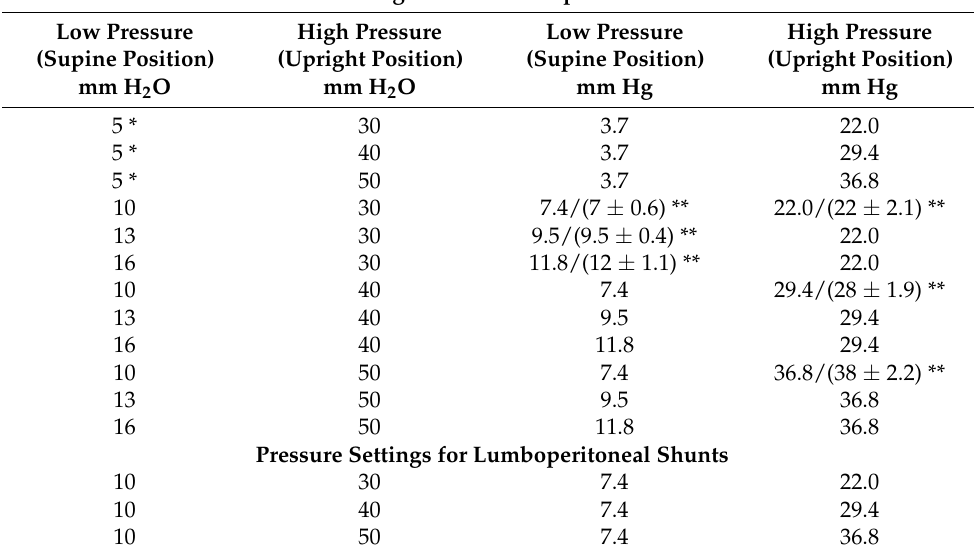
Table 1. Closing pressures stated by the manufacturers (left) compared to the pressure values found in the tested shunts by Czosnyka at the UK Shunt Evaluation Laboratory (right, in parenthesis) for different models of Dual-Switch